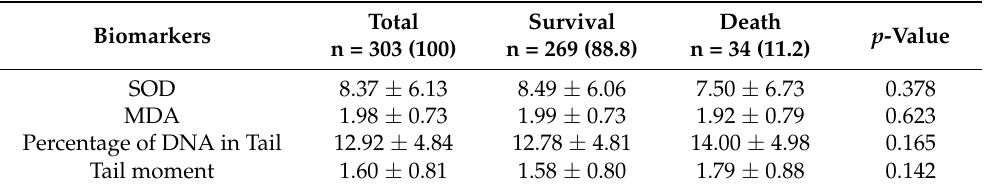
Table 4. Levels of biomarkers associated with oxidative stress and DNA damage between the participants who survived and those who died.